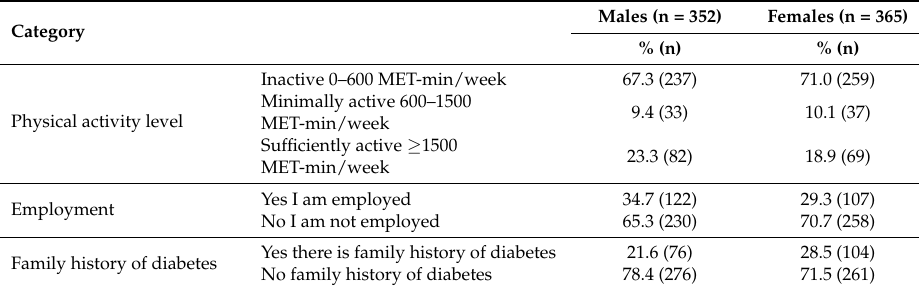
Table 2. Percentage distribution of employment history, family history of diabetes, and physical activity categories of inactive, minimally and sufficiently active for ELS young adults aged 18 to 28 years based on MET-min/week.